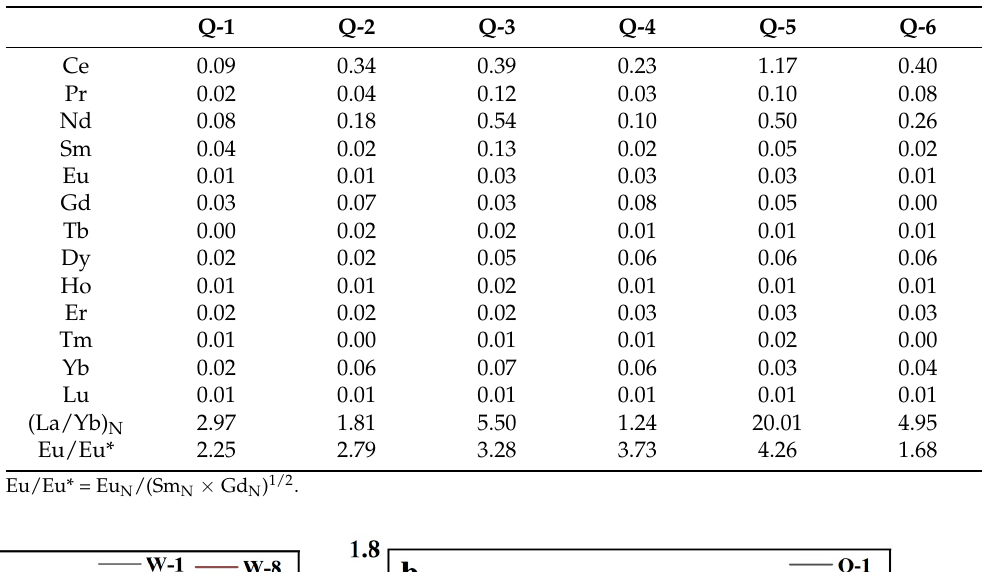
Table 6. Qing dynasty jadeite rare earth elements (ppm).